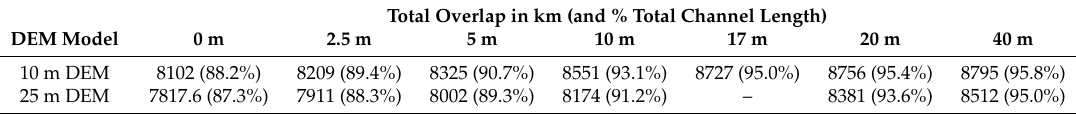
Table 1. Total km of the predicted channels in stream networks derived from DEM models that overlap or lie within varying distances of the existing channels in the Grand River